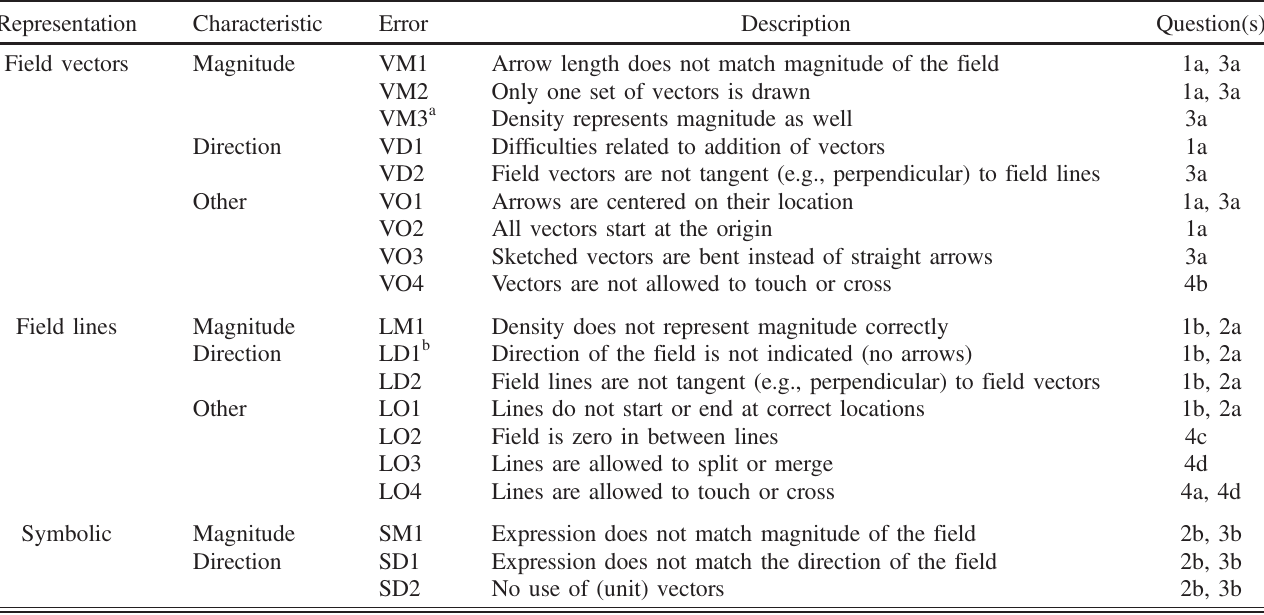
TABLE I. Final categorization of student difficulties with vector representations. The first four columns indicate how the difficulties were categorized in terms of representations and characteristics of the field. The numbers in the last column correspond to the questions on the VFR test (Fig.